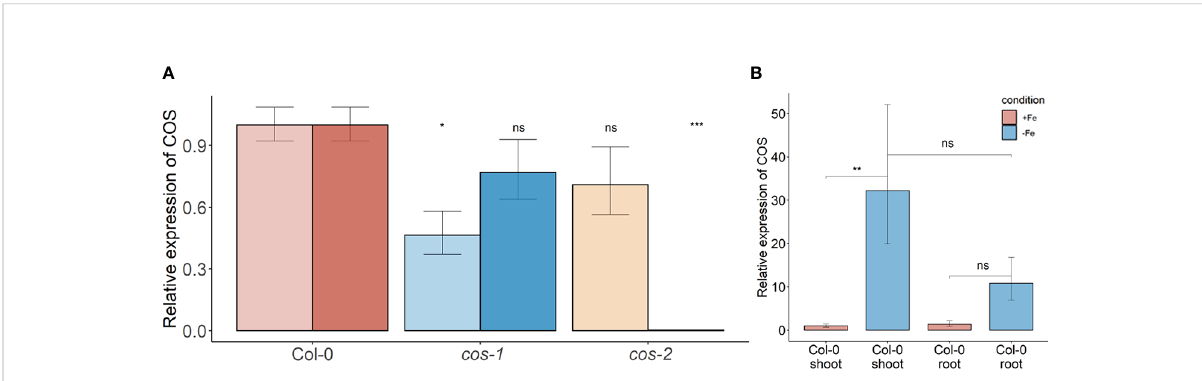
FIGURE 2 COS expression in WT and T-DNA mutants. (A) Two sets of primers were used for RT-PCR. The primer set upstream of the T-DNA insertion is designated with the lighter color, while the primer set downstream of the insertion is designated with darker color. Seedlings were grown on 1/ 2X MS agar with 50 m M Fe-EDTA for 5 d followed by a growth period of 3 d either on Fe-suf fi cient or Fe-de fi cient MS agar medium. Bars represent means ± SD of relative transcript levels normalized to ACT2 (n = 3). (B) Expression levels of COS transcript in WT shoots and roots. Seedlings were grown on 1/2X MS agar with 50 m M Fe-EDTA for 14 d followed by a growth period of 3 d either on Fe-suf fi cient or Fe-de fi cient MS agar medium. Bars represent means ± SD of relative transcript levels normalized to ACT2 (n = 3). * represents p-value ≤ 0.01. ** represents p-value ≤ 0.001, *** represents p-value ≤ 0.0001, ns, not signi fi